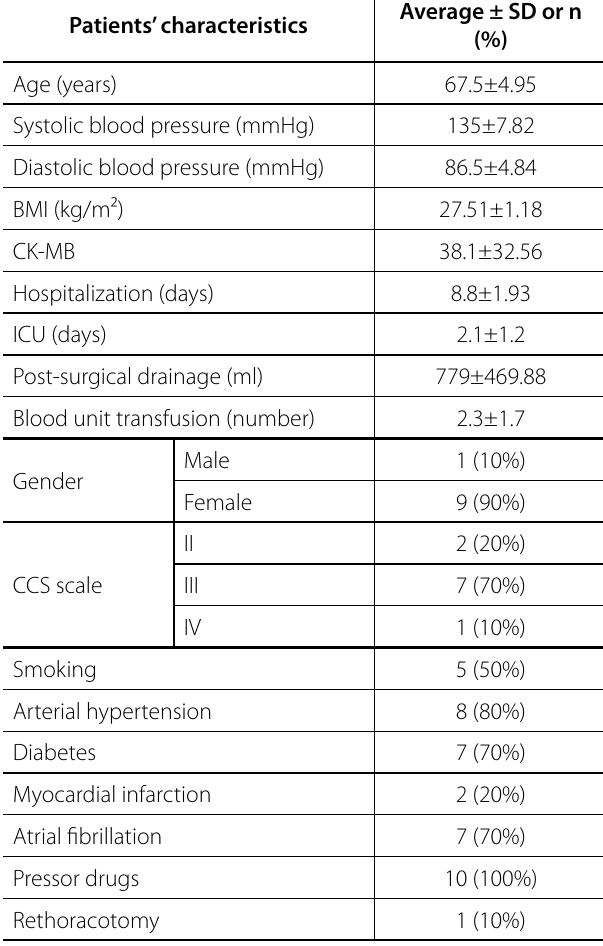
Table 1 . Patients’ clinical